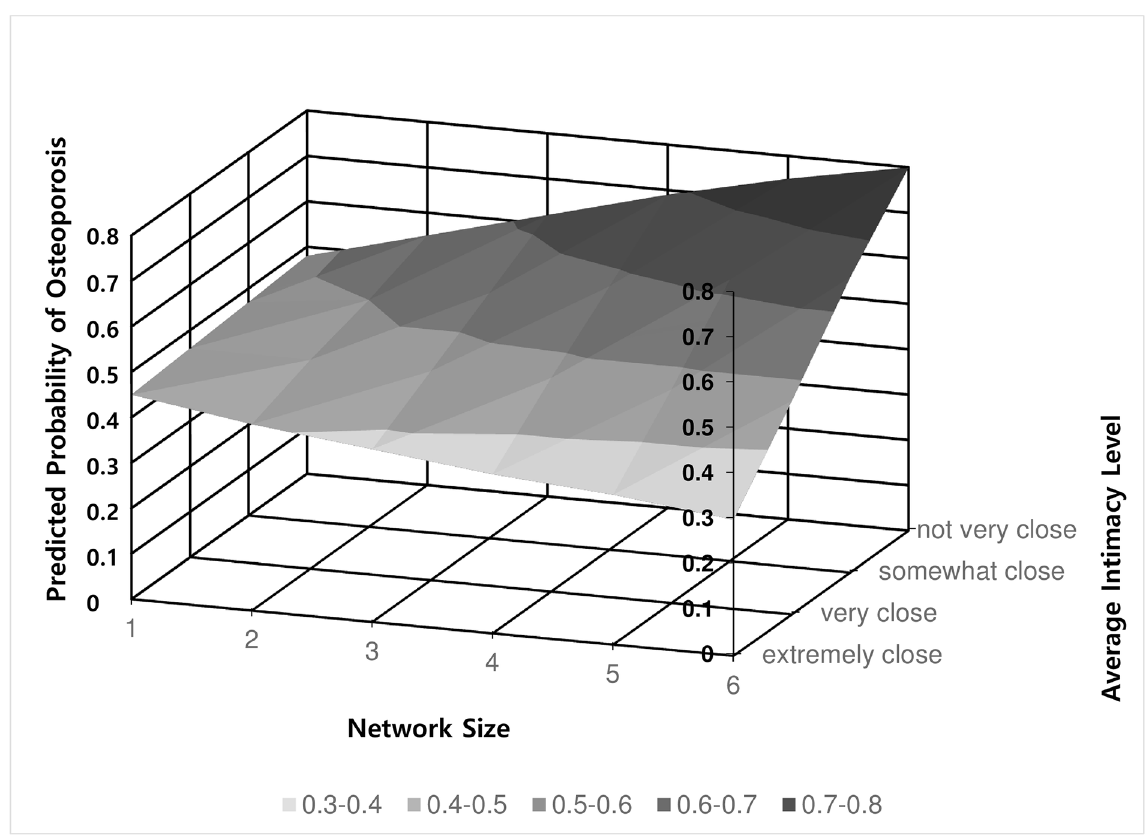
Fig 2. Probability of osteoporosis predicted by the social support network size and averageintimacy level. The predicted probabilityof having osteoporosis was calculatedfor each social support network size and averageintimacy level. The estimated predicted probabilitywas basedon the logistic regressionwhich was adjustedfor other covariatessuch as marital status, age, BMI, drinking, smoking, exercise, household income, educational level, living area, and instrumental activitiesof daily living.